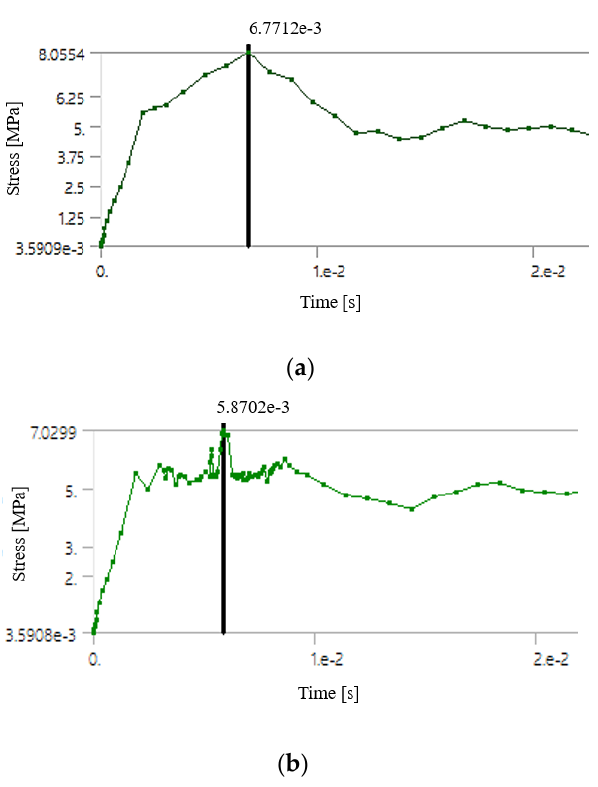
Figure 7. Principal stress history in cavity wall concrete with time. ( a ) The Drucker-Prager model. ( b ) The Menetrey-William model.